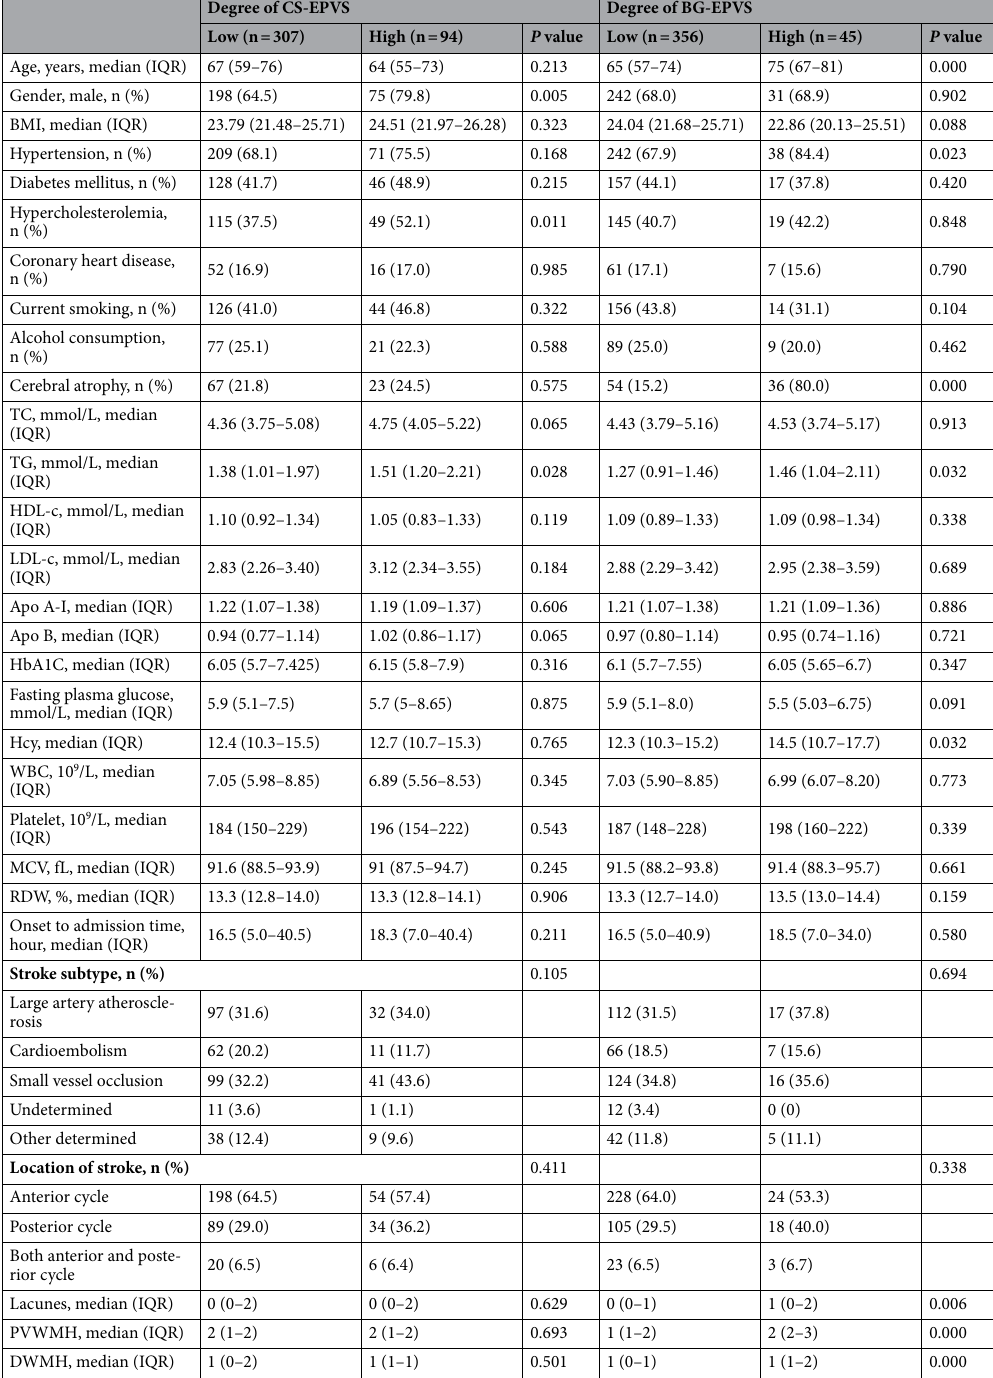
Table 1. Comparison of characteristics between patients with high and low EPVS degree in BG and CS. EPVS enlarged perivascular spaces, BG basal ganglia, CS centrum semiovale, IQR interquartile range, BMI body mass